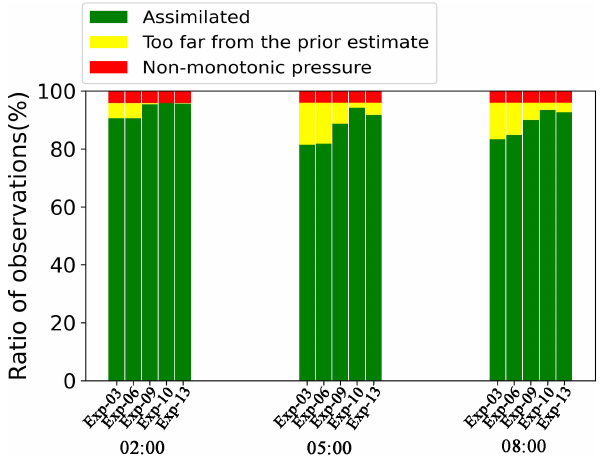
Figure 12. Time evolution of the ratio of observations that are as- similated or rejected by the WRF-DART system for different exper- iment designs with different outlier threshold values and observa- tion